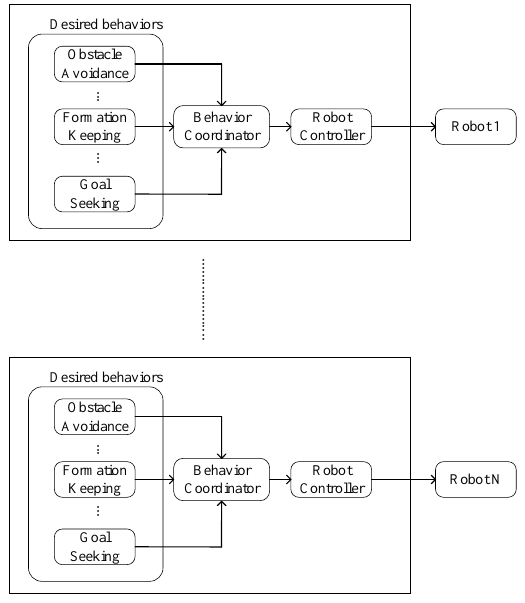
Figure 11. Behavior-based approach Giulietti et al. exploits the behaviors of migrating birds into formation flight control [52]. The control signal is constructed by summing outputs of two sub-controller, a trajectory controller and a position controller. The gains for two controllers are determined by minimizing a quadratic cost function. Swarm intelligence scheme for multiple aerial vehicles is studied in [53]. Three behaviors, namely collision avoidance, velocity matching, and flock centering are combined to attain the procedures to reach the